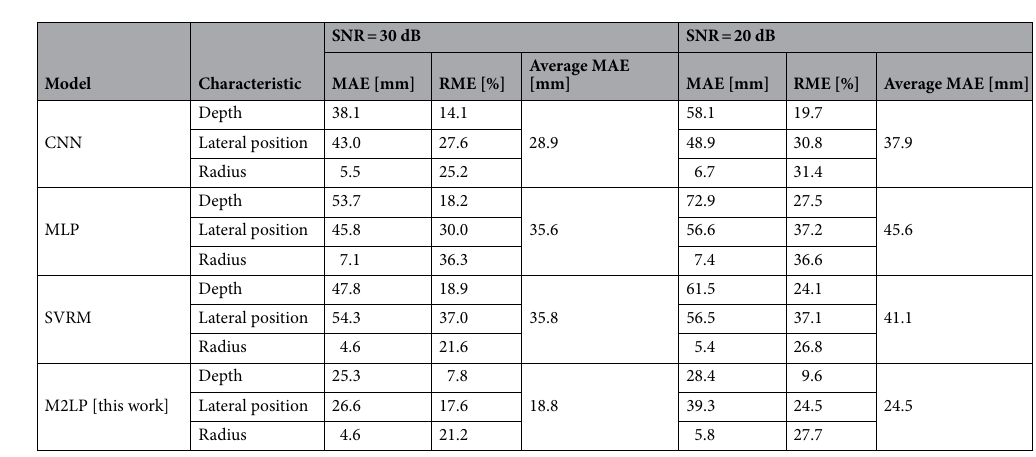
Table 9. Prediction accuracy of characteristic parameters of the buried object for all models (dataset DS4 with 500 samples). Considered scenarios include noisy data with SNR of 30 dB and 20